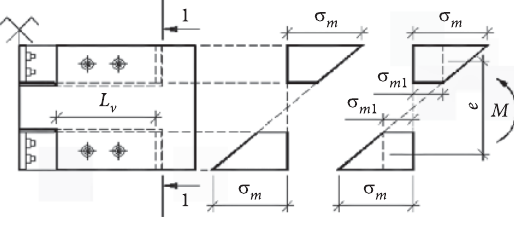
Fig. 4. Normal stresses form bending moment in connection